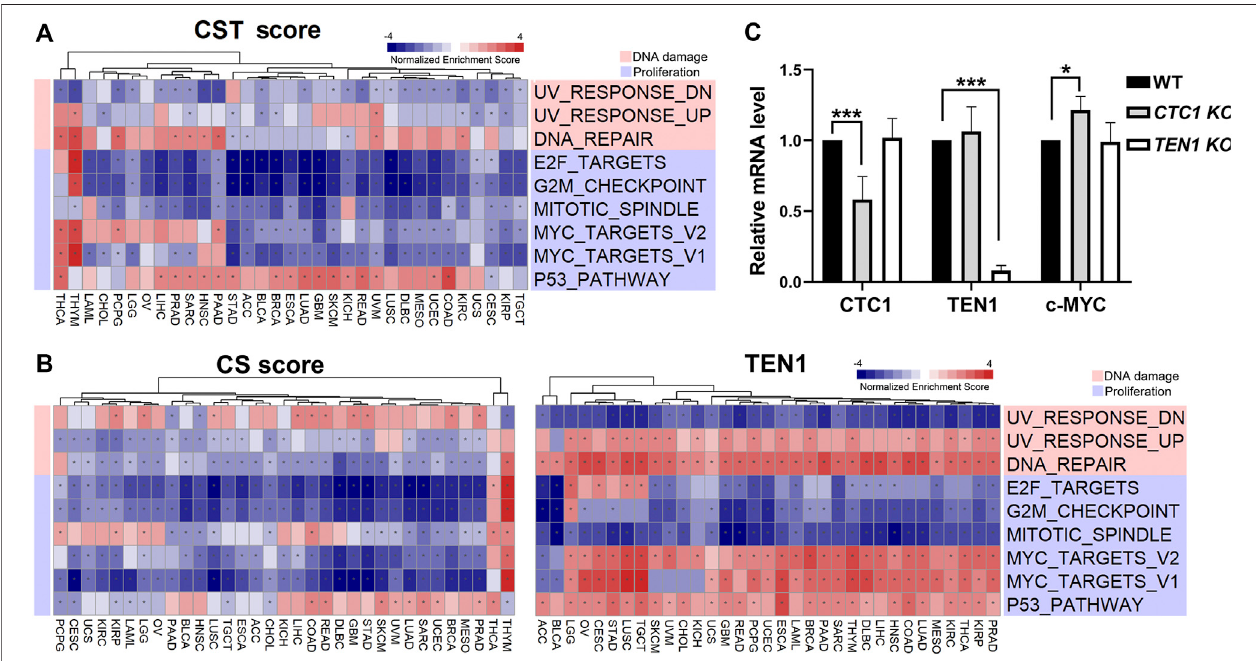
FIGURE 4 | CST-correlated pathways: (A) heatmap showing normalized enrichment score of signi fi cant hallmark sets of CST score. (B) Heatmap showing normalizedenrichmentscoreofsigni fi canthallmarksetsofCSscore(left)andTEN1expression(right).Eachcolumnrepresentsacancertype,andeachrowrepresentsa hallmarkset.Redrepresentspositivenormalizedenrichmentscores,andbluerepresentsnegativeenrichmentscores.The “ * ” symbolincellsindicatesthatenrichmentis statistically signi fi cant. Unsupervised clustering used the Euclidean distance metric with complete linkage. The functions of the signi fi cant hallmark sets are annotated in different colors. (C) Quantitative PCR was carried out to determine the mRNA levels of endogenous CTC1, TEN1, and c-MYC in the wild type, CTC1, or TEN1 conditional knockout HCT116 cells. The differences were tested by Student ’ s t test, *** p < 0.001.